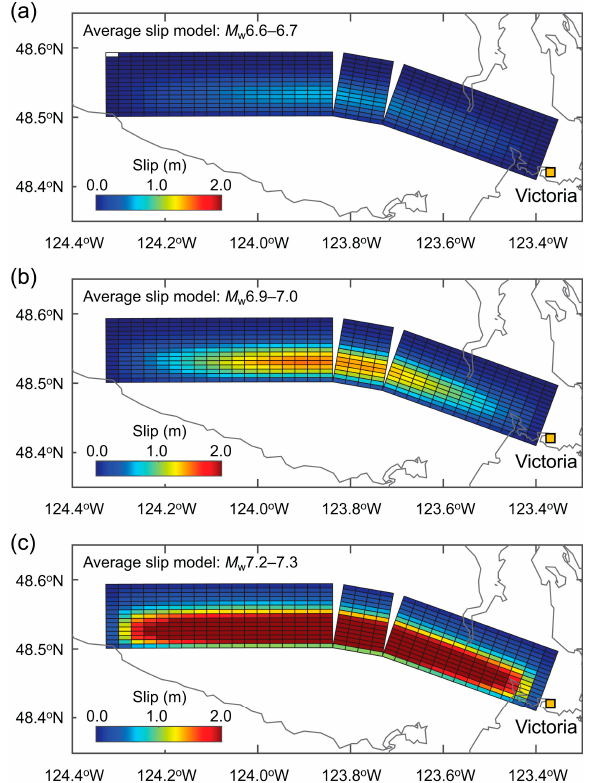
Figure 6. Average earthquake slip distributions of the 1000 stochastic source models: ( a ) M w 6.6–6.7 scenario, ( b ) M w 6.9–7.0 scenario, and ( c ) M w 7.2–7.3 scenario.